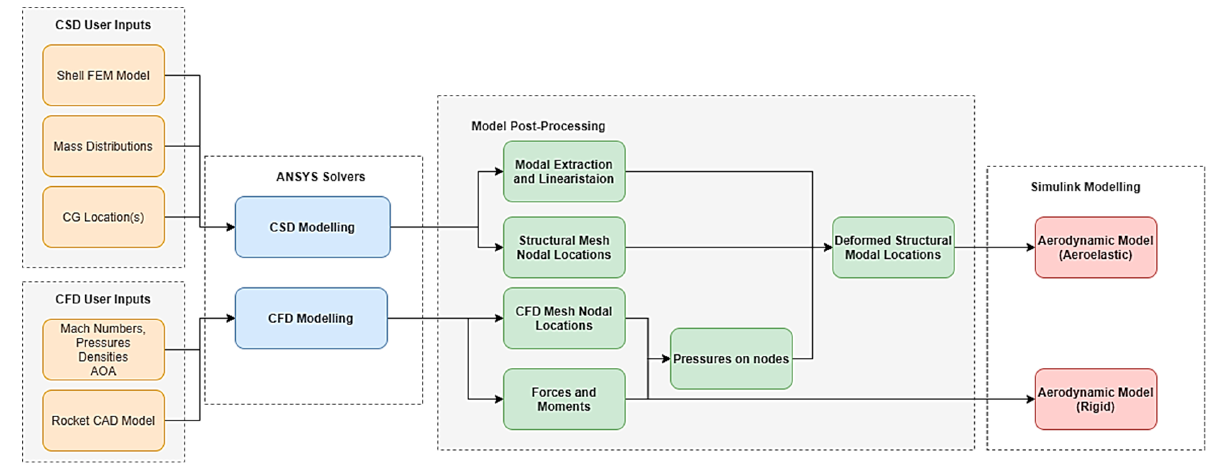
Figure 6. Overview of the methodology for the determination of aeroelastic